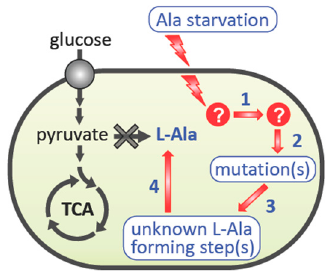
Figure 7. Model depicting stress-induced mutagenesis leading to the emergence of L-alanine pro- totrophic suppressor mutants. The L-alanine auxotrophic strain HYE032 senses the stress of L-alanine starvation, which leads to activation of a DNA-related metabolic pathway (Step 1). Subsequently, a genome-wide mutation(s) is introduced (Step 2) in a subpopulation of the cells. Some of the clones obtain, by chance, the ability to increase their intracellular level of pyruvate (Step 3), which provides HYE032 cells with an adequate amount of L-alanine to proliferate (Step 4).